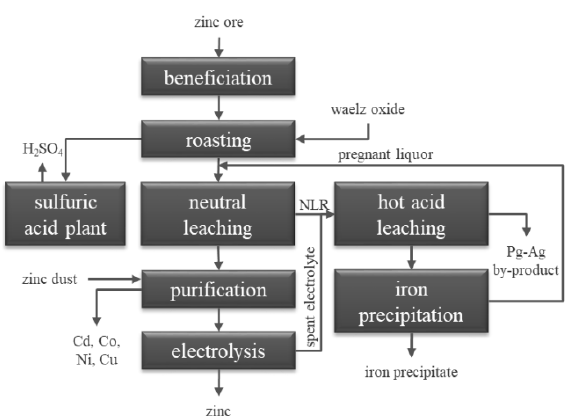
Figure 1. Flow sheet of zinc production by roasting, neutral- and hot-acid leaching, and electrowinning [2,3]. NLR: neutral leaching residue.